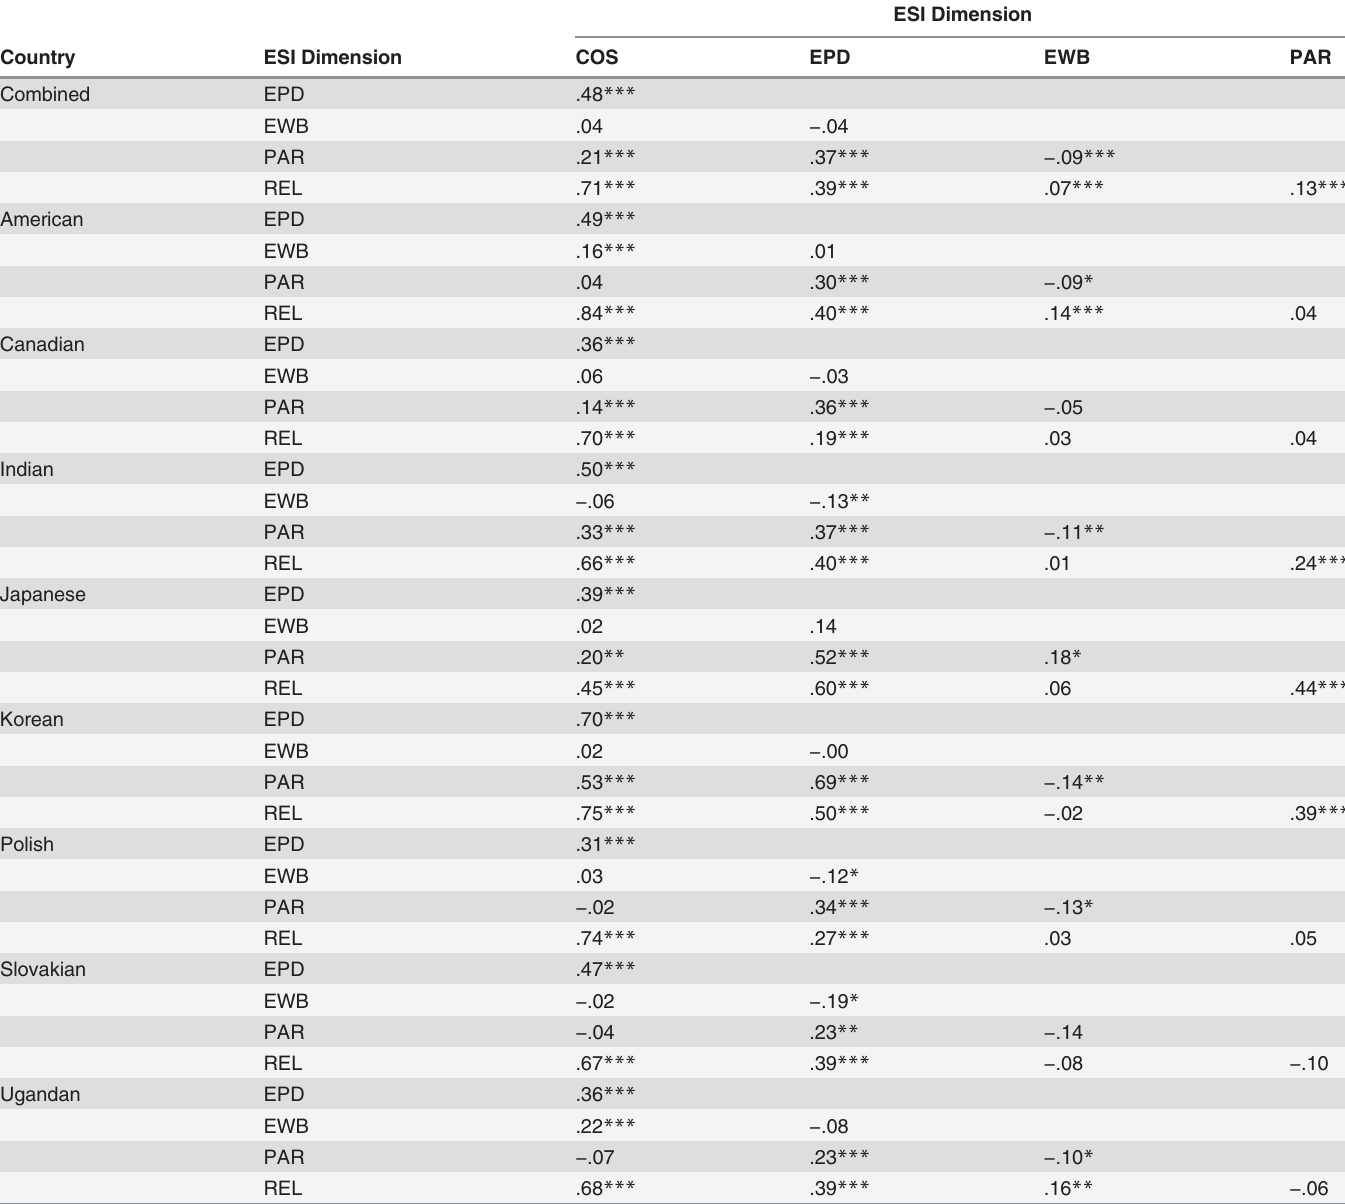
Table 8. Inter-correlations of ESI-R Dimensions for Total Combined and Country Samples.